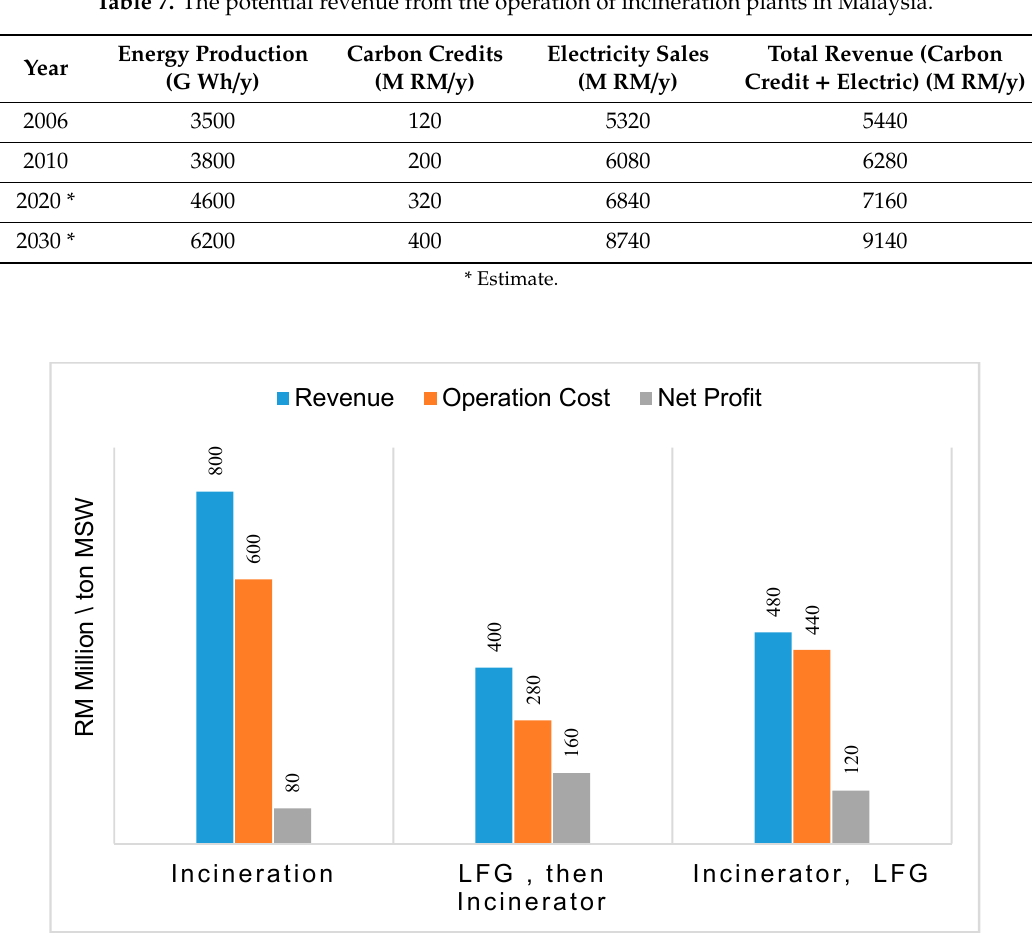
Figure 11. Electricity generation and revenue via landfill gas for the years 2010, 2015, and 2020 [33]. •